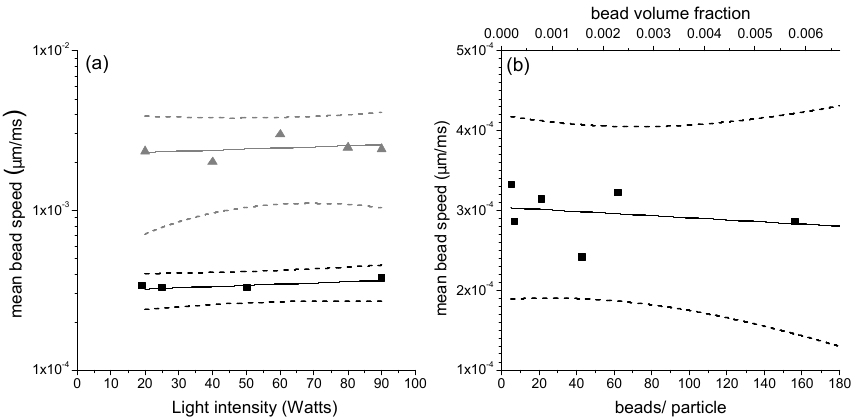
Fig. 8. (a) Mean melamine bead speed vs. light intensity of the halogen light source on the microscope in particles composed of ∼ 100wt% glycerol (black squares) and ∼ 100wt% olive oil (grey triangles) at room temperature, (b) Mean melamine bead speed vs. number of beads/particle or bead volume fraction in particles composed of ∼ 100wt% glycerol. In (a) and (b) , the solid lines represent the best fit functions and the dashed lines represent the upper and lower 95% prediction